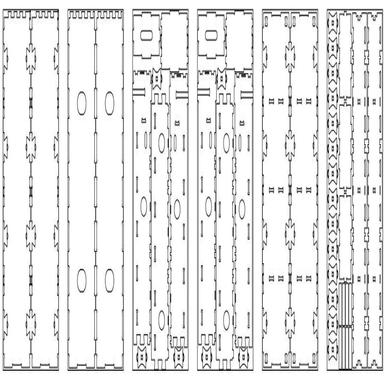
CNC cutting path, first 4 sheets for the floor and last 2 sheets for the wall.